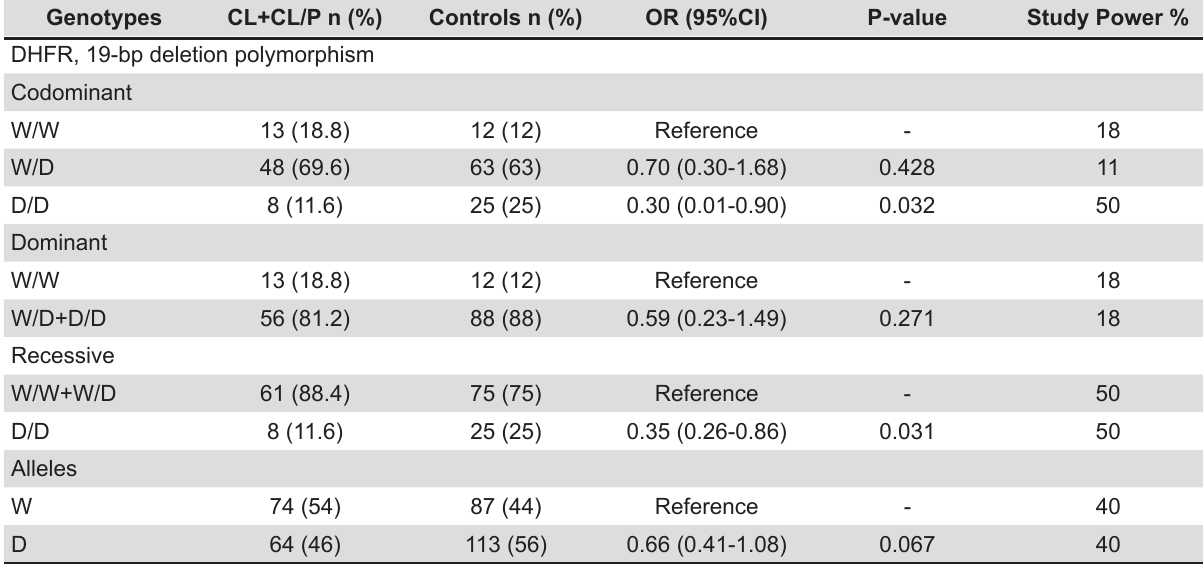
(CL/P)=cleft lip with or without cleft palate